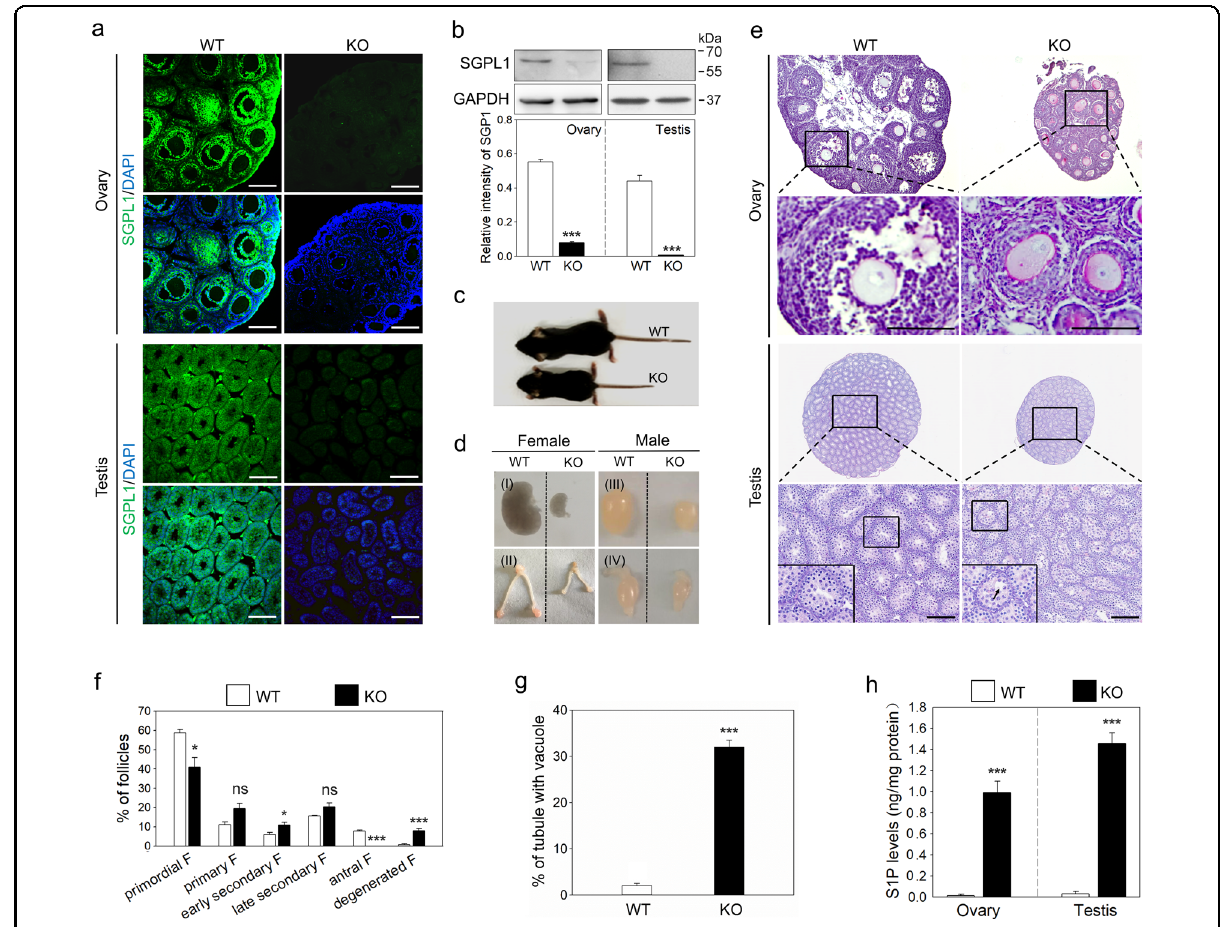
Fig. 2 The effects of Sgpl1 deletion on S1P levels and gonad development. Detection of SGPL1-knockout ef fi ciency in 14-day-old ovaries and 21-day-old testes by immuno fl uorescence ( a ) and western blotting ( b ). ( n = 3 independent experiments). The nuclei were counterstained by DAPI (blue). GAPDH was used as a loading control. Scale bars: 100 μ m. Gross morphology of 21-day-old WT and KO mice ( c ) and gonads and deputy gonads ( d ) (I, ovary; II, uterus; III, testis; IV, epididymis; n = 3 independent experiments). e Histological analysis of 21-day-old ovaries and 25-day-old testes from WT and KO mice. ( n = 3 independent experiments). The small black boxes indicate the enlarged areas, as shown in the following images. The black arrow shows the vacuole in the tubules. Scale bars: 100 μ m. f Quanti fi cation of the numbers of follicles of different types in ovaries from WT and KO mice. Serial sections were used for the count. ( n = 3 independent experiments. The total number of six ovaries was used in each group). F follicles. g The percentage of tubules with vacuoles in testes from WT and KO mice. ( n = 3 independent experiments. The total number of 600 tubules was scored in each group). h The levels of S1P in ovaries and testes from WT and KO mice ( n = 3 independent experiments. The total number of 24 ovaries or testes was used in each group). Bars indicate the mean ± SEM. ns no signi fi cance, * p < 0.05 and *** p < 0.001 vs. the WT